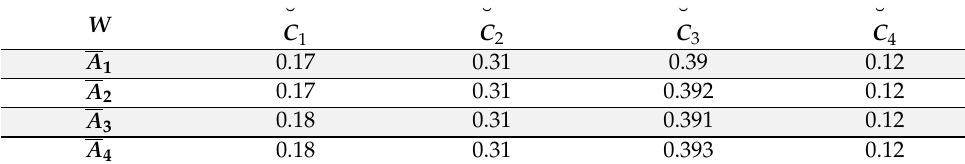
Table 16. Matrix in which we find the value of W.